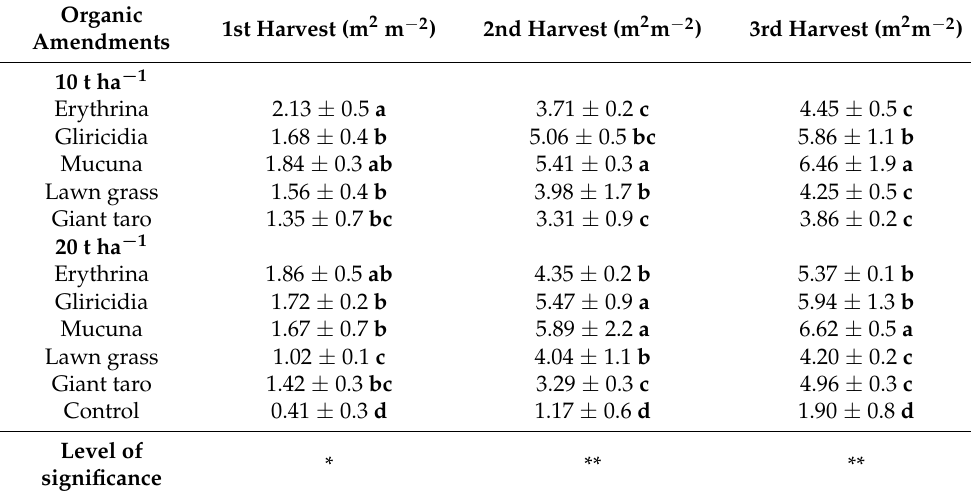
Table 4. Interaction effect of organic amendments with two application rates (10 and 20 t ha − 1 ) at three harvesting times (14, 28 and 42 DAT) on means leaf area index (m 2 m − 2 ) ( ± standard deviation) of Chinese cabbage.